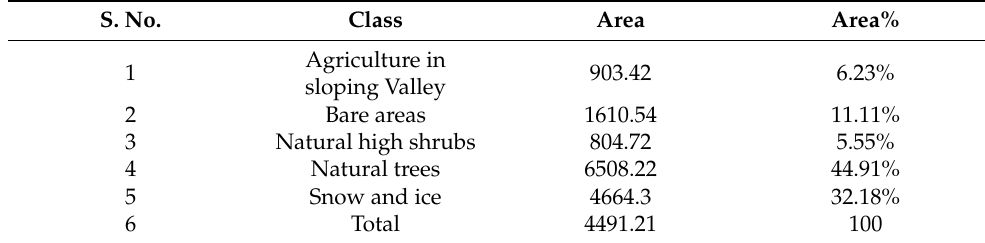
Table 3. Land use classes and their respective areas.